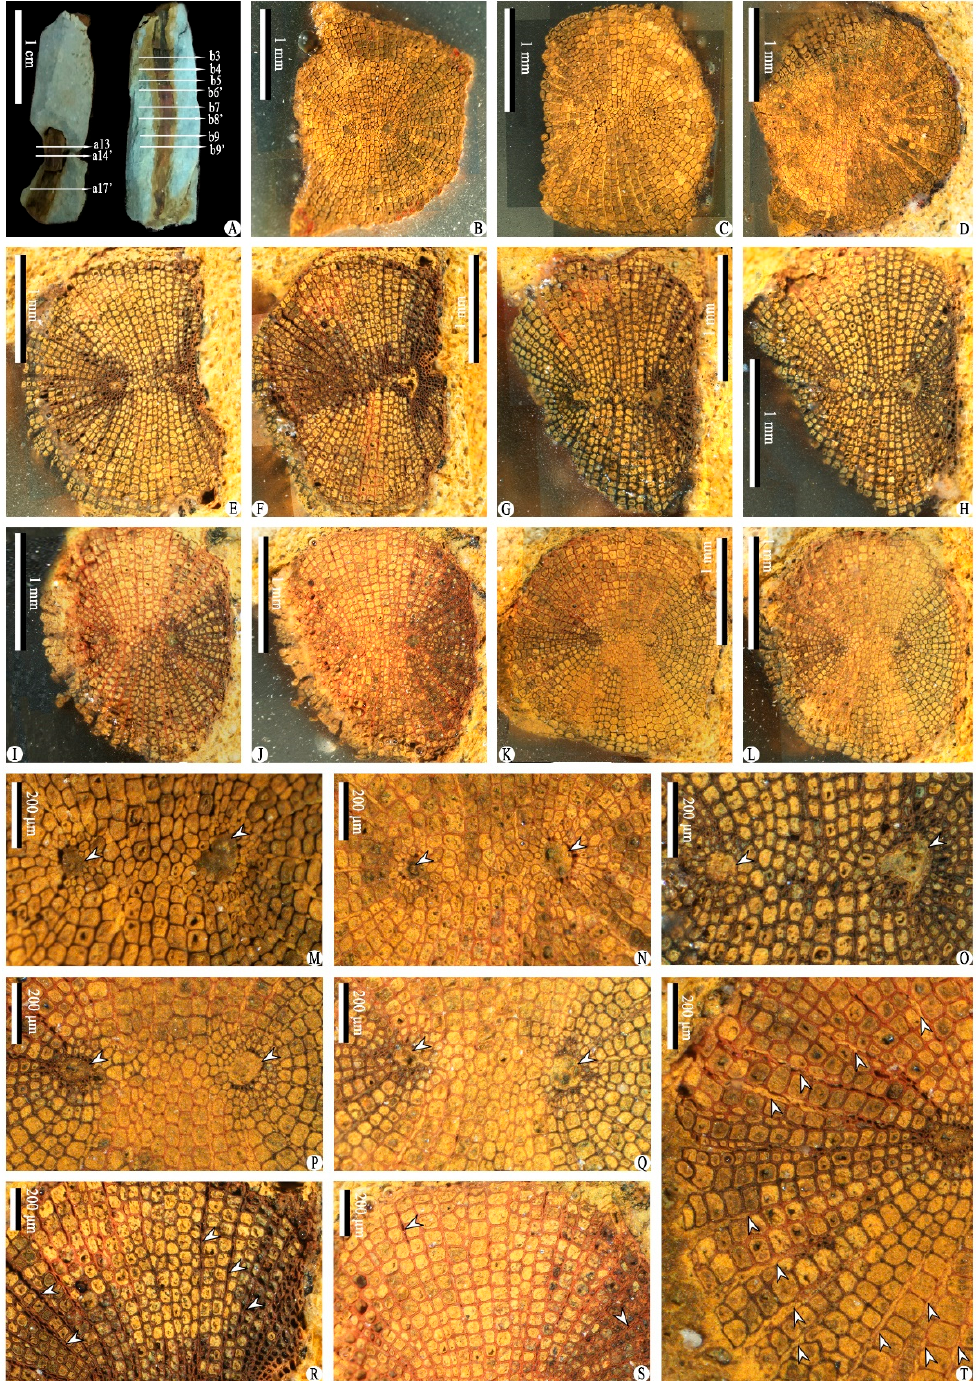
Figure 7. Anatomy of Xinhangia spina gen. et sp. nov. from Guangde City, Anhui Province, China. ( A ) Two axes before transverse sectioning. ( B – D ) Serial sections of the left axis in A , showing clepsydroid-shaped primary xylem surrounded by secondary xylem (a13, a14 ′ , a17 ′ ). ( E – L ) Serial sections of the right axis in A , showing clepsydroid-shaped primary xylem surrounded by secondary xylem (b3, b4, b5, b6 ′ , b7, b8 ′ , b9, b9 ′ ). ( M – Q ) Close-up views of primary xylem of B , D , G , K , L , respectively, showing two prominent protoxylem poles (arrows) and primary xylem tracheids. ( R – T ) Close-up views of secondary xylem of F , J , L , respectively, showing radial files of secondary xylem tracheids and rays. Arrows indicate rays.